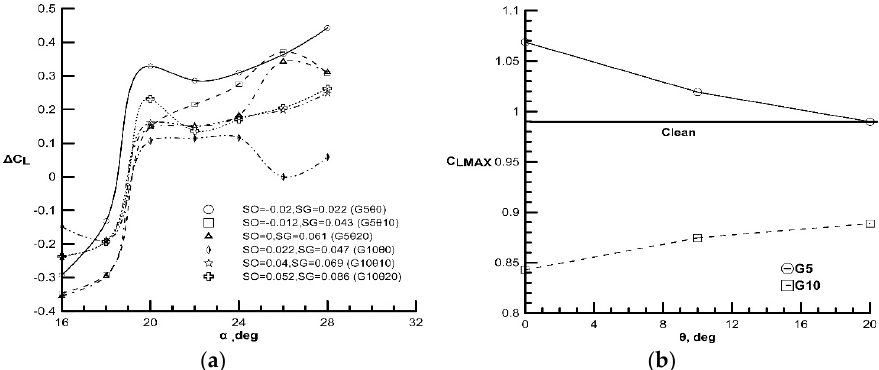
Figure 3. Effect of slat gap and angle on ( a ) the lift increment relative to the clean wing and ( b ) the maximum lift coefficient.